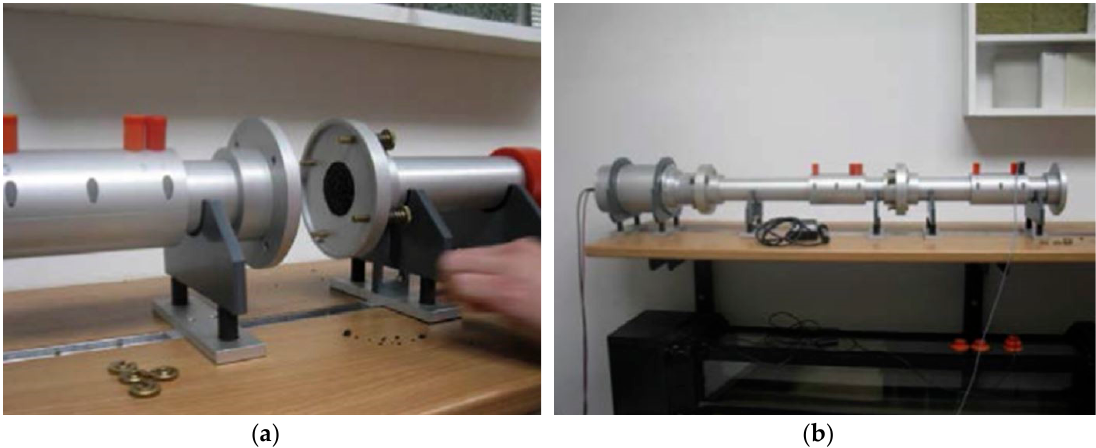
Figure 3. Installing the impedance tube for characterizing the noise absorption of PU samples: ( a ) Connecting the sample holders; ( b ) completely installed impedance tube device.